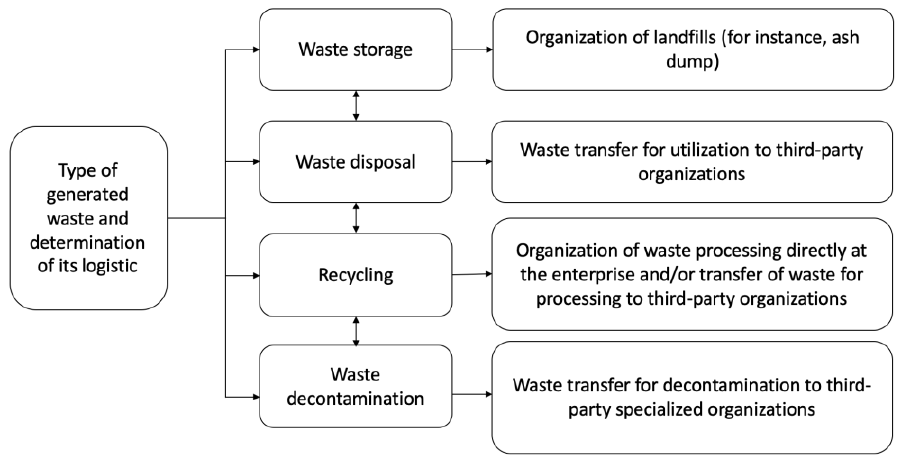
Figure 2. A typical logistics scheme for waste management at traditional energy enterprises (made by authors using data from [27–29].